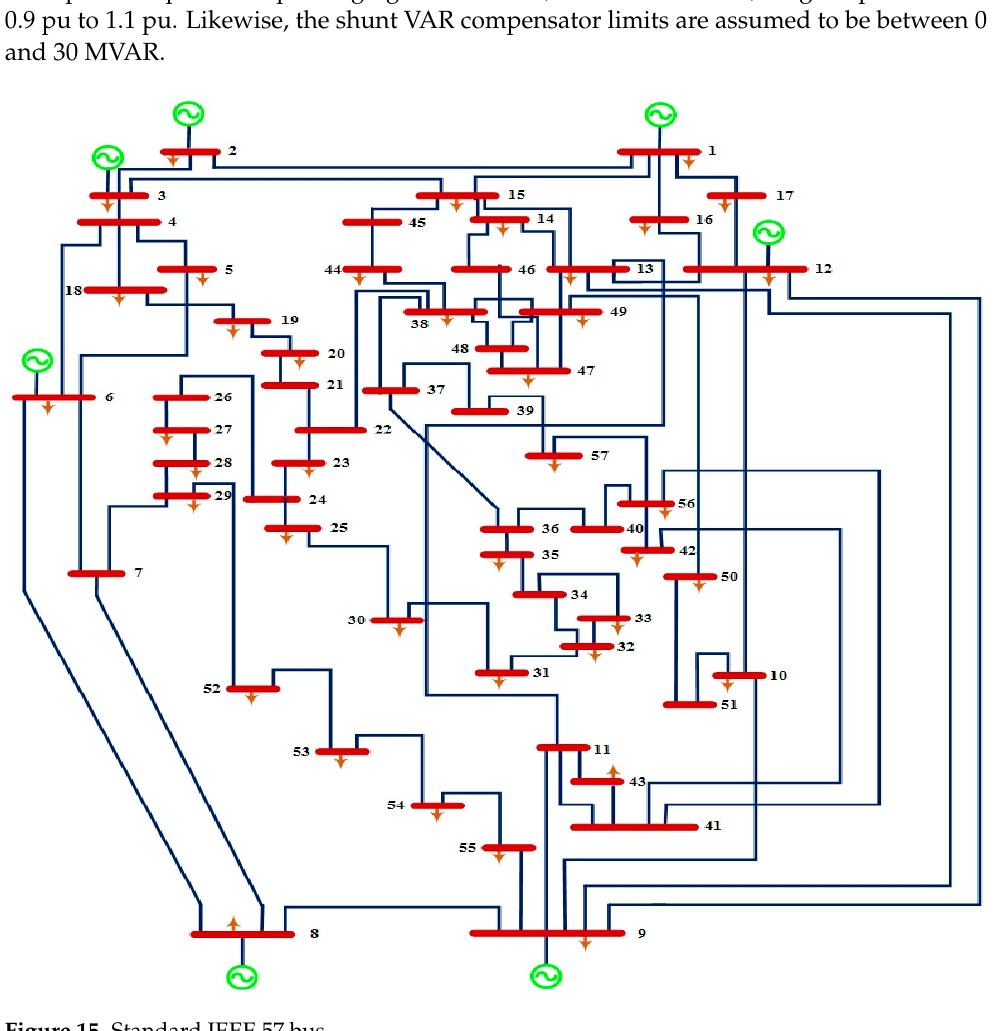
Figure 15. Standard IEEE 57 bus.